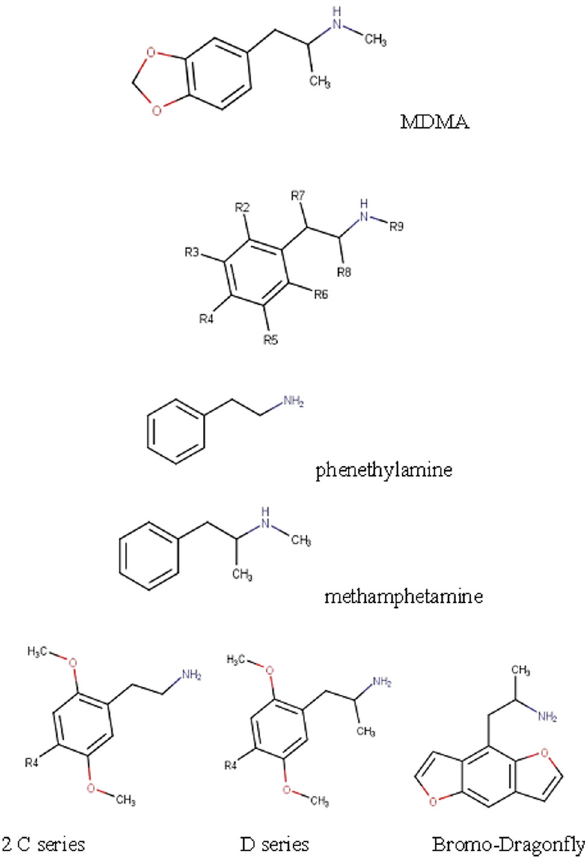
Figure 1: Chemical structures of some members of the phenethyl - amines family of drugs [ 296 ] . Reprinted from Drug and Alcohol Dependence, 154, Gael Le Roux, Chloe Bruneau, Benedicte Lelievre, Marie Bretaudeau Deguigne, Alain Turcant, Patrick Harry,